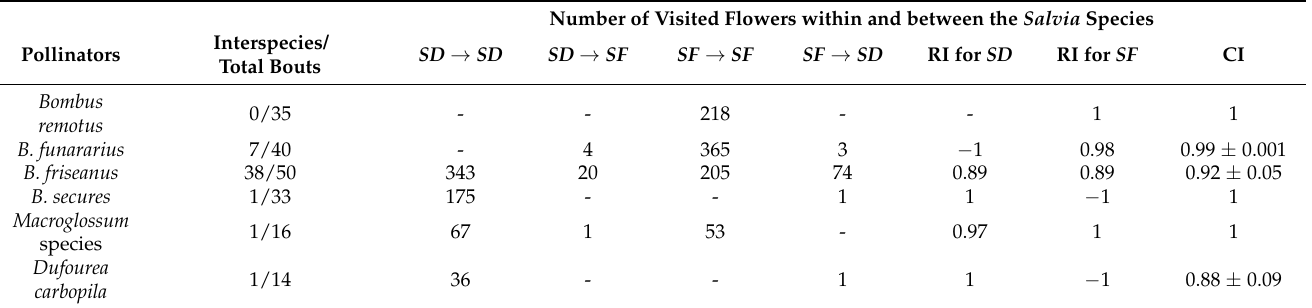
Table 4. Intra- and inter-specific foraging bouts, degree of reproductive isolation (RI), and floral constancy (CI) for S . digitaloides ( SD ) and S . flava ( SF